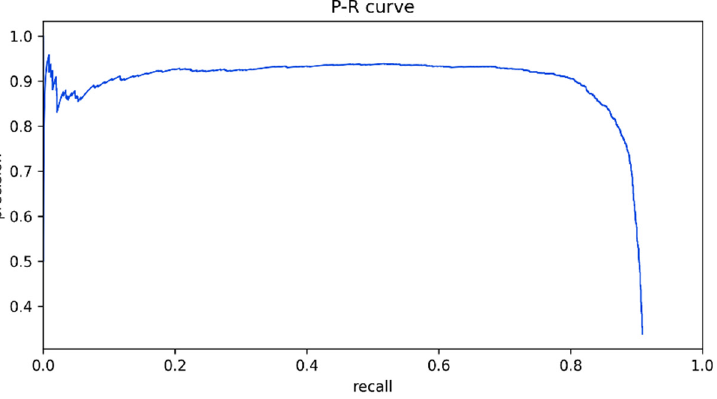
Figure 8. An example of a P–R curve.